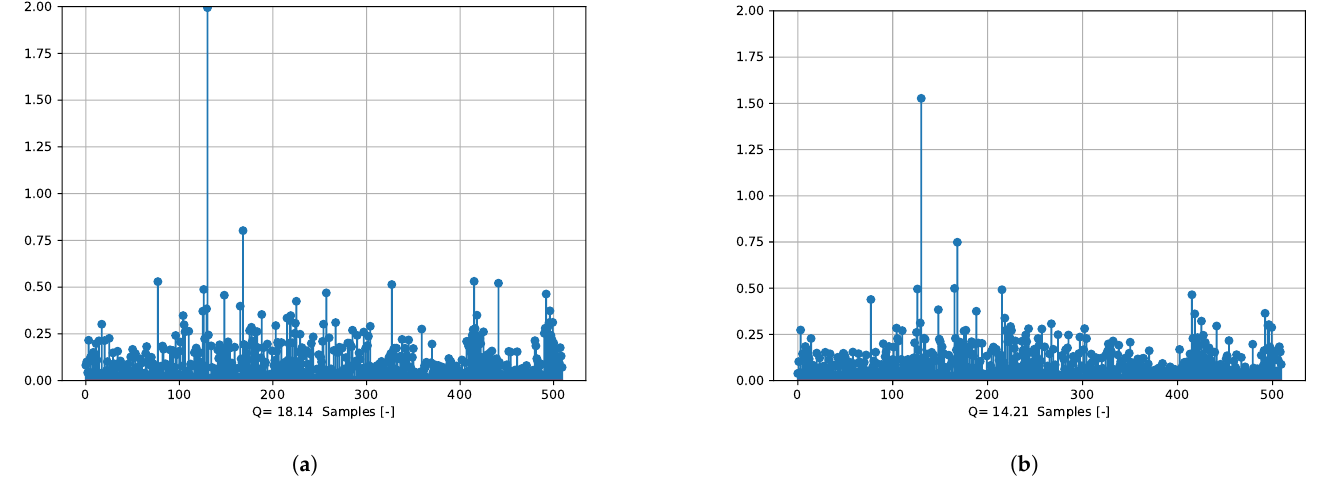
Figure 12. Multiple shaft rotations (electric angle), sine, and cosine estimation error. ( a ) Using a single ANN. ( b ) Using multiple